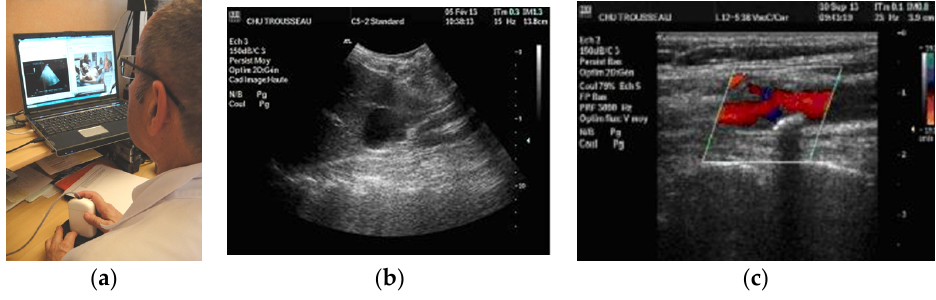
Figure 2. ( a ) RA expert center computer screen with video of the patient (left) and echographe screen (right); ( b ) Renal cyst image obtained using RA; ( c ) Carotid bifurcation with atheromatous plaque in color Doppler using RG.